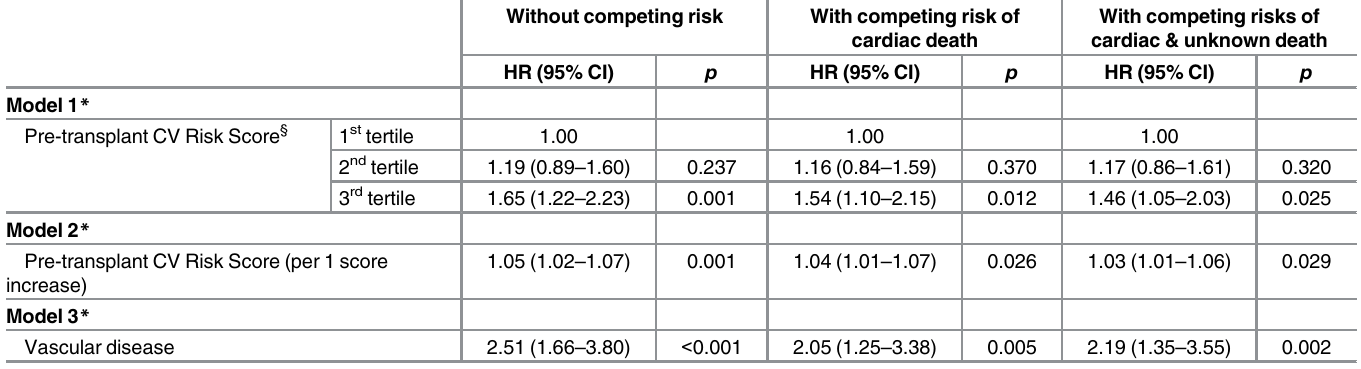
Table 4. Hazard ratios for allograft failure with adjustment for competing risks in 2,902 subjects.